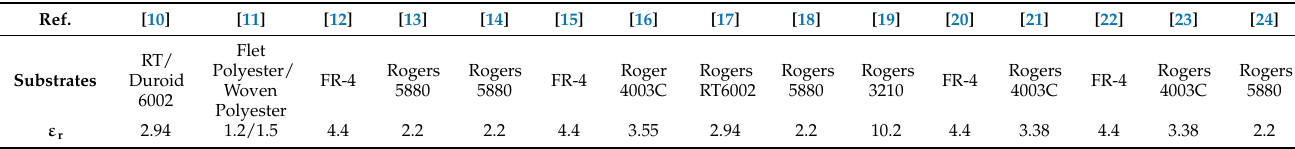
Table 2. Substrates used in the design of the RF-EH